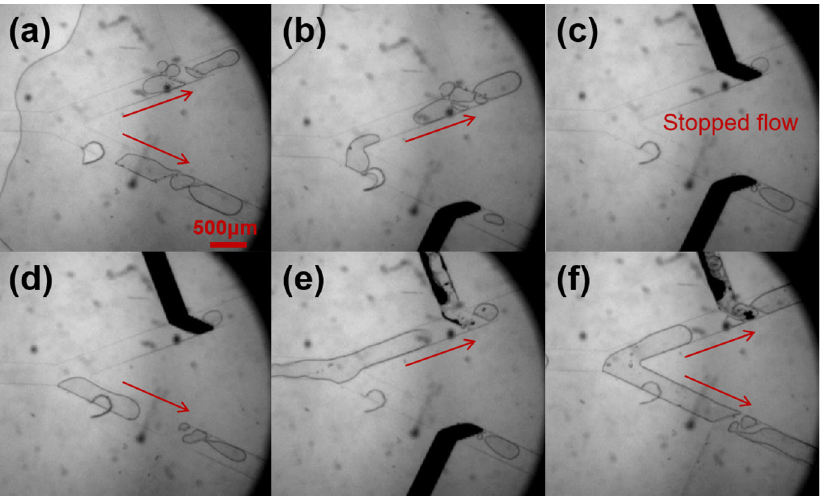
Figure 8. Bubbles’ flow direction manipulated by two microvalves in Y-shaped channel. ( a ) Before two valves were closed. ( b ) The lower side valve was closed. ( c ) Both the upper and lower side valve were closed. ( d ) The lower side valve was opened. ( e ) The upper side valve was opened. ( f ) Both the upper and lower side valve were opened.